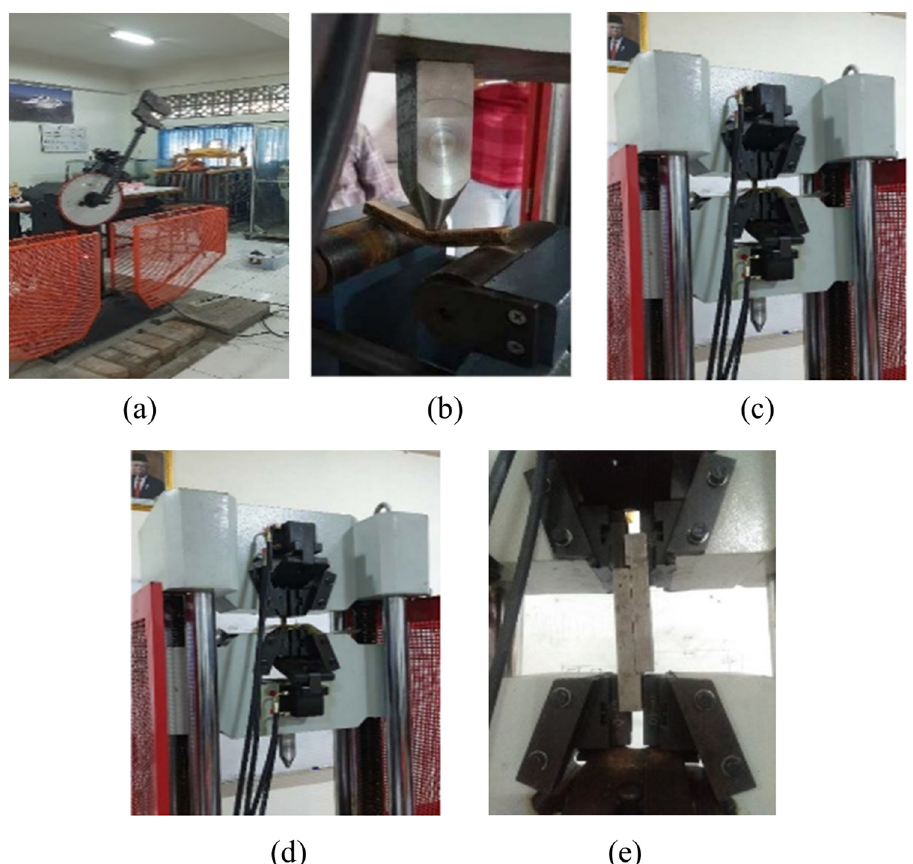
Figure 4: The di ff erent testing schemes of LBCs: ( a ) impact test, ( b ) fl exural test, ( c ) tensile test, ( d ) V - notched beam test, and ( e ) shear